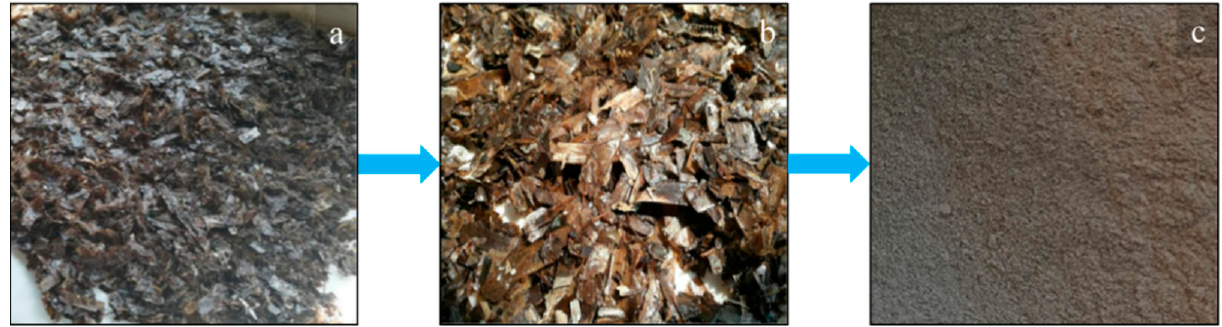
Figure 1. Raw OFI cladodes before ( a ) and after ( b ) washing and after chopping ( c ).